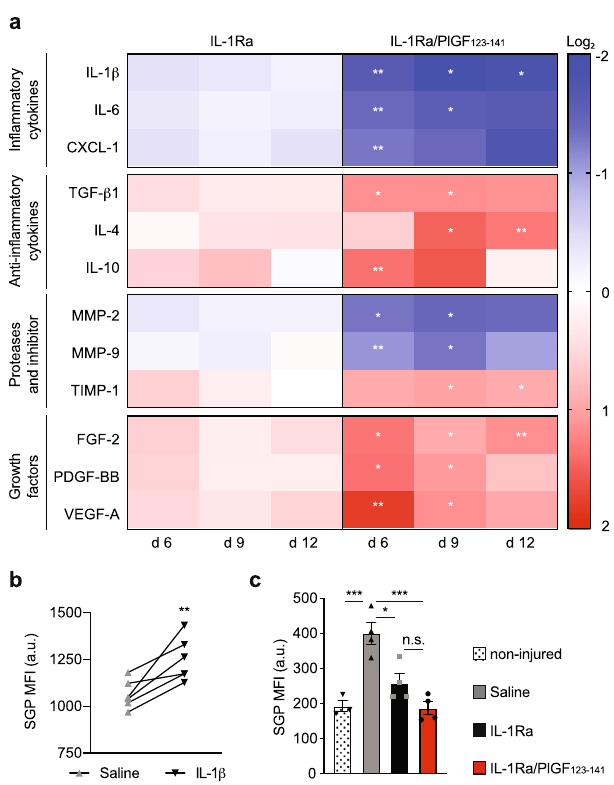
Fig. 4 Super-af fi nity IL-1Ra leads to a pro-healing microenvironment. a Full-thickness wounds were created in Lepr db/db mice and treated with saline control or IL-1Ra variants (0.5 μ g of wild type, equimolar IL-1Ra/ PlGF 123 – 141 ). After 6, 9 and 12 days wound concentrations of cytokines, MMPs, TIMP-1 and growth factors were measured by ELISA. The heat map shows fold change in log 2 over treatment with saline. n = 4. b Dermal fi broblasts were cultured with IL-1 β (1 ng/ml) or saline control. After 9 days, SA- β -gal activity was assessed using senescence green probe (SGP). Graph shows median fl uorescence intensity (MFI). n = 6. c Full- thickness wounds in Lepr db/db mice were treated with saline or IL-1Ra variants. After 9 days, SA- β -gal activity in wound fi broblast was assessed by fl ow cytometry using SGP MFI. SA- β -gal activities were compared to fi broblasts in non-injured skin samples. n = 4. For all panels, data are means ± SEM. For ( a ), two-way ANOVA with Bonferroni post hoc test for pair-wise comparisons between IL-1Ra and IL-1Ra/PlGF 123 – 141 . For ( b ), two- tailed Student ’ s t test. For ( c ), one-way ANOVA with Bonferroni post hoc test for pair-wise comparisons. * P ≤ 0.05, ** P ≤ 0.01, *** P ≤ 0.001. ns non- signi fi